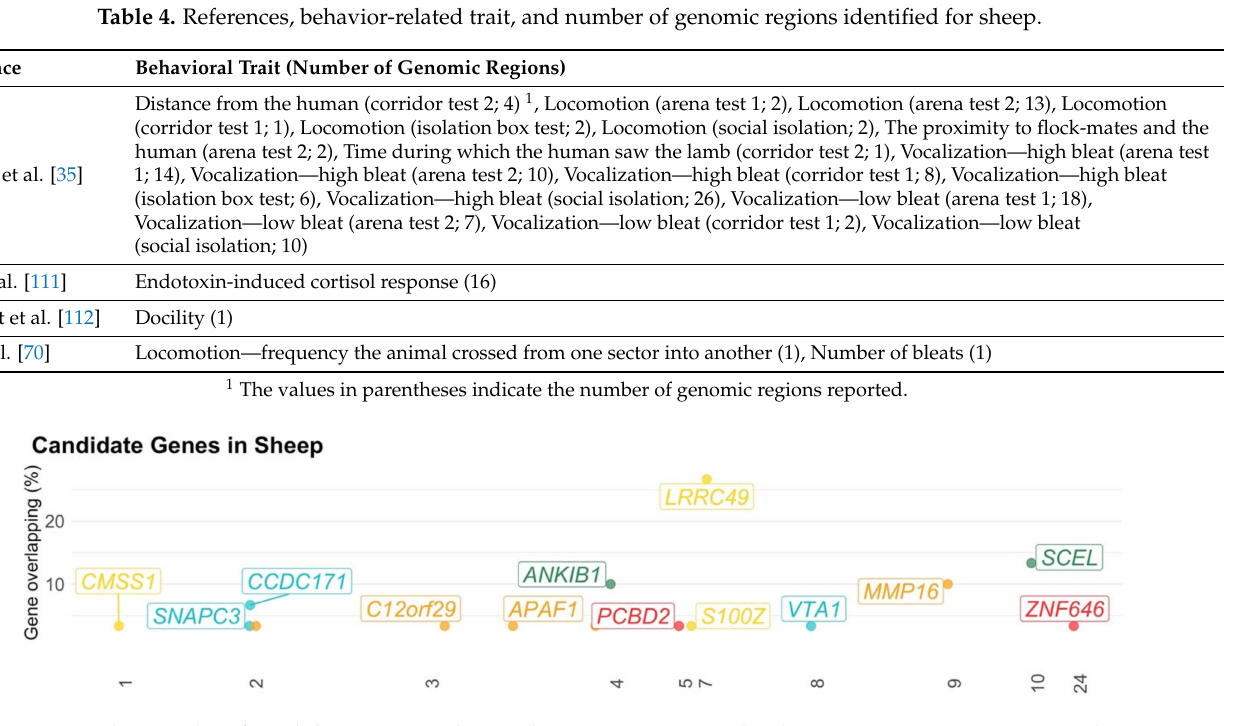
Figure 7. Manhattan plot of candidate genes in sheep. The x-axis represents the chromosome; y-axis represents the gene overlapping in percentage (i.e., ratio of times of gene appearance and total number of genomic regions); the color represents the chromosomes; labelled boxes represent the symbol for all annotated